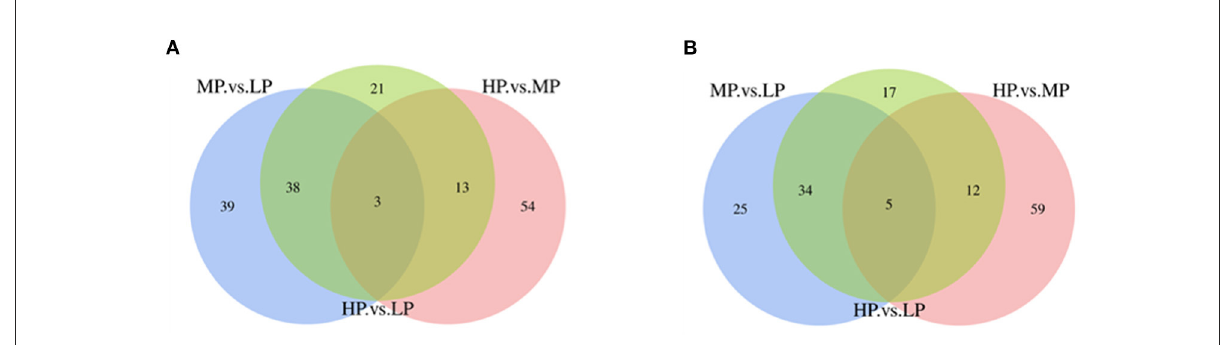
FIGURE1 The Venn diagram of differentially expressed proteins. (A) The Venn diagram of differentially expressed up-regulated proteins; (B) Differentially expressed down-regulated protein Venn diagram.